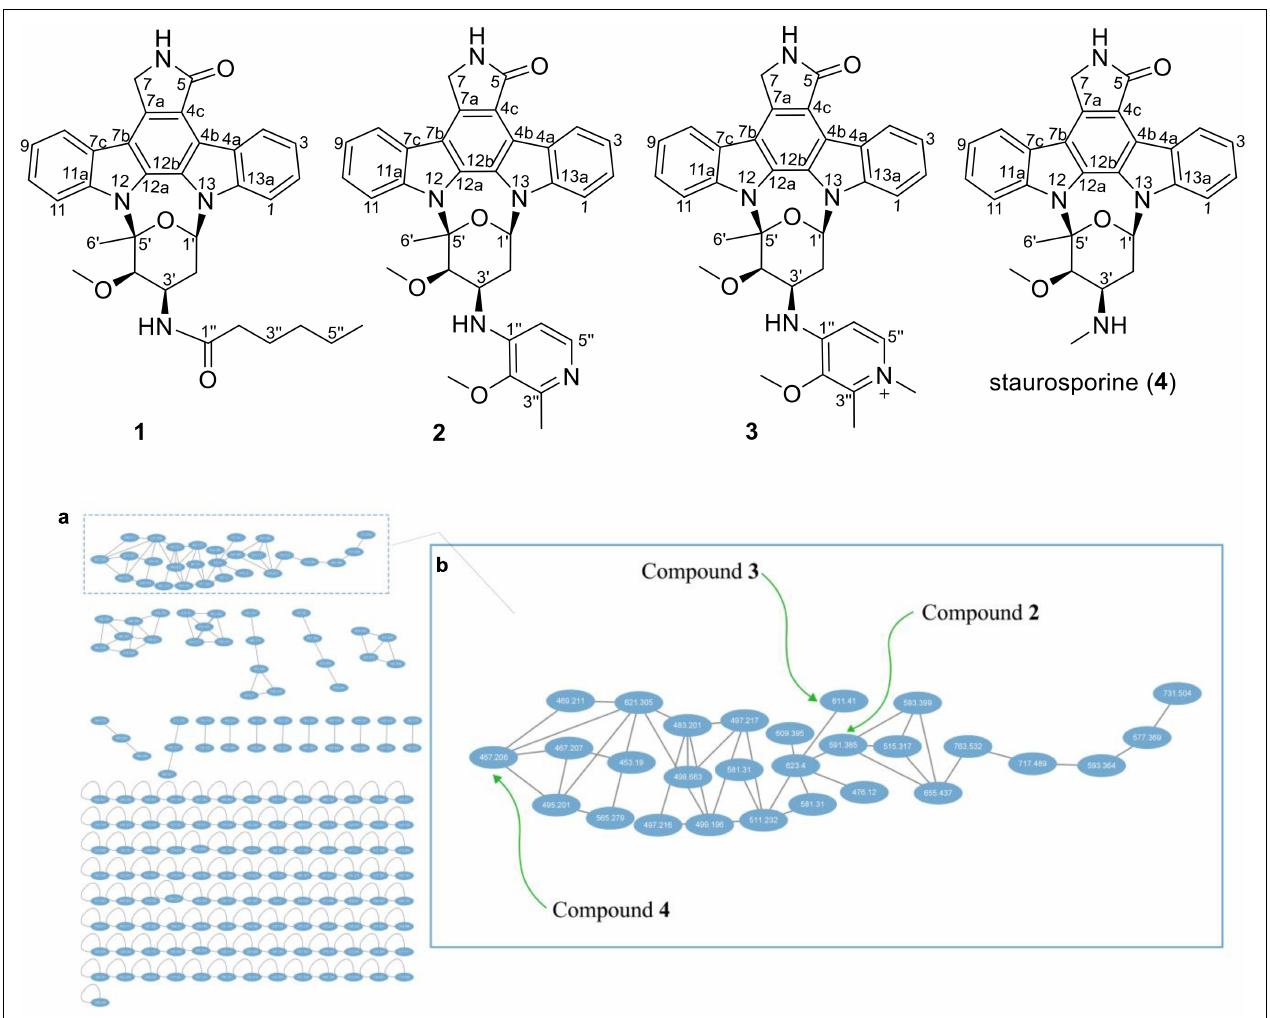
FIGURE 1 | Structures 1 – 4 and the molecular networking of the extract (MeOH layer) from Streptomyces sp. OUCMDZ-5380 (a) and the compound cluster of indolocarbazole family observed in the molecular networking